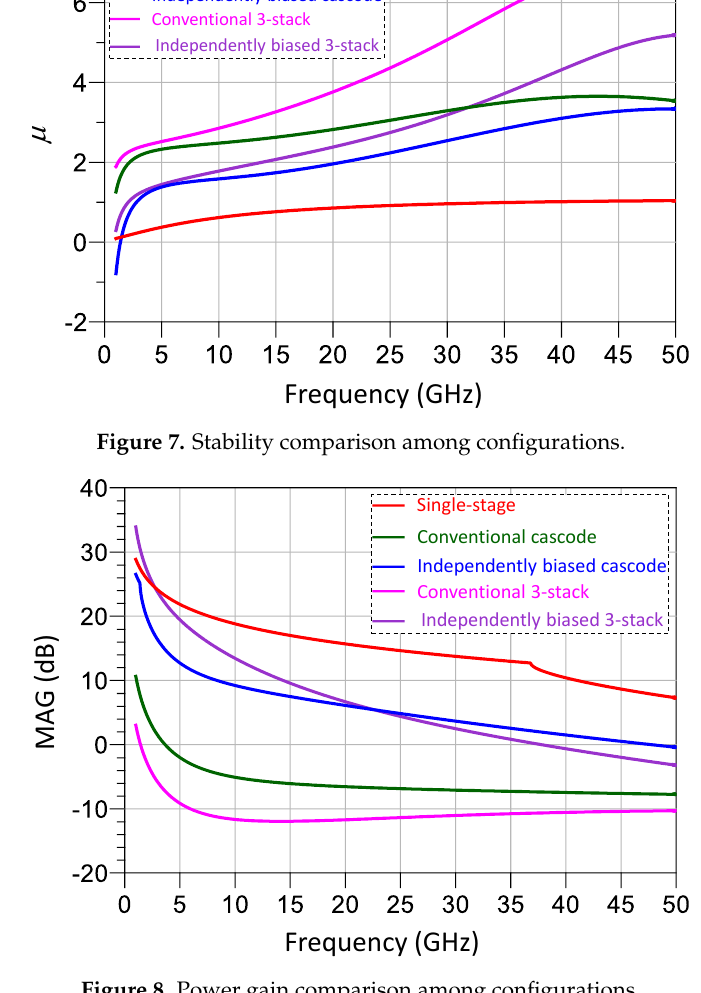
Figure 8. Power gain comparison among configurations.